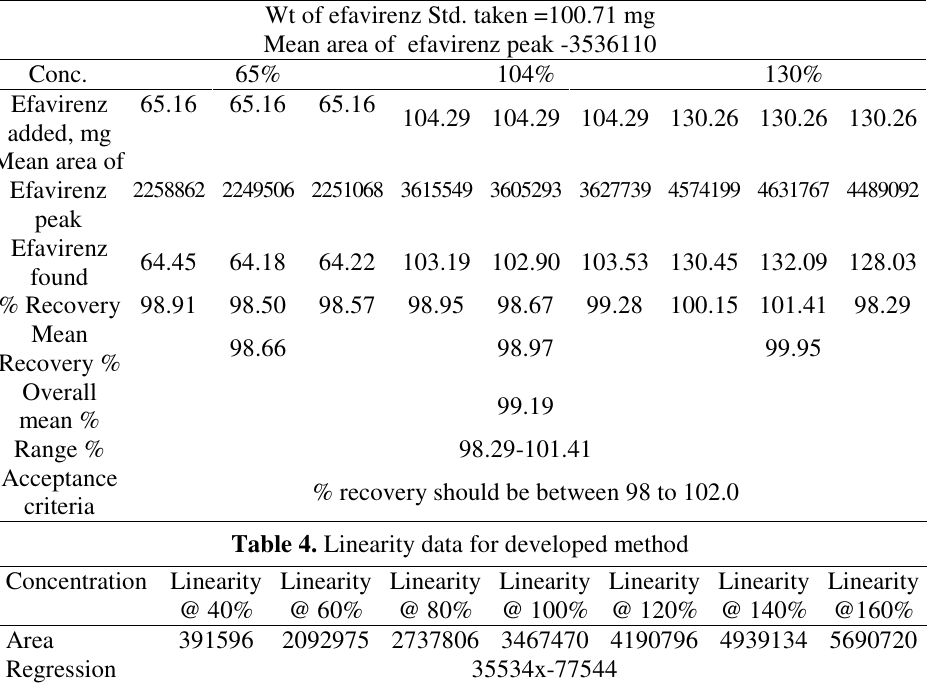
Table 3. Accuracy data for developed method